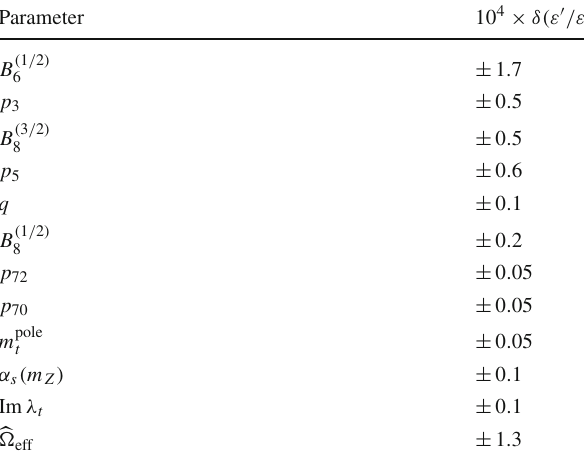
Table 6 Table of the absolute error of ε (cid:2) /ε for benchmark point (12) with input parameters from (4) and (12). The absolute error of ε (cid:2) /ε from these parametric uncertainties becomes 10 4 × δ(ε (cid:2) /ε) = 2 . 3